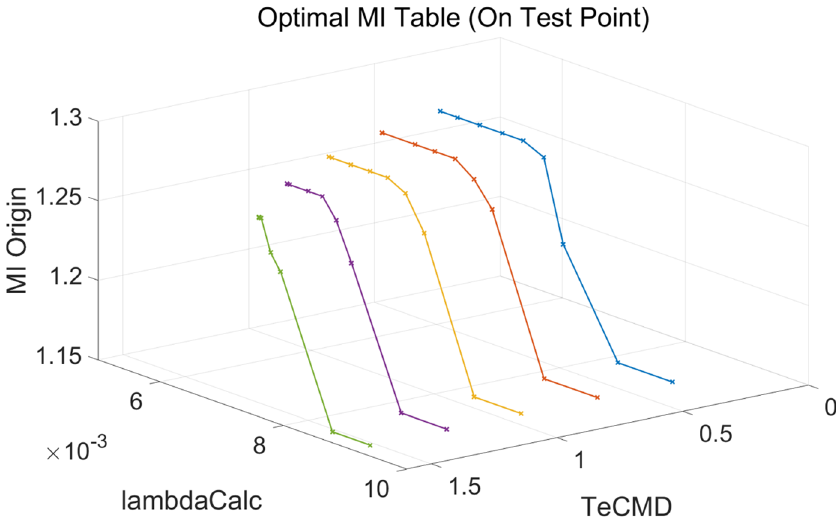
Figure 16. Optimal MI expressed based on flux–torque command.